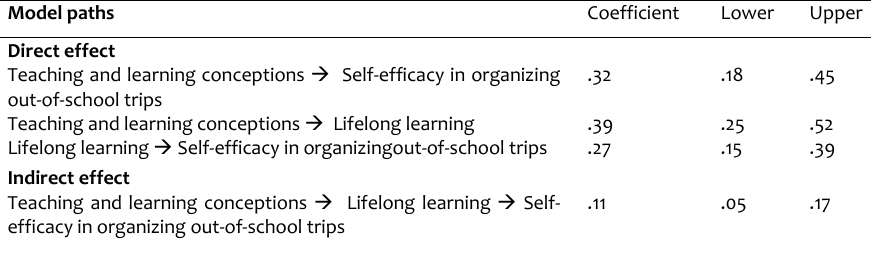
Table 4. The results of the bootstrapping analysis